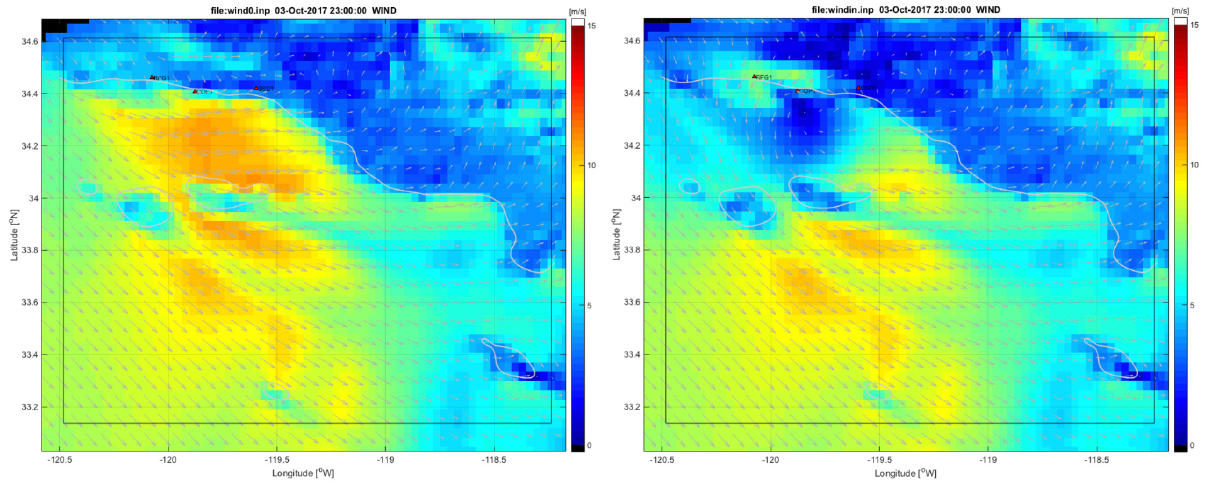
Figure 6. A 10-m wind field comparison for COAMPS first guess (left) and SWAN HF assimilation winds (right) for 3 October 2017 at 2300z. Notice the strong winds in the Santa Barbara Channel in the first guess that is not present in the assimilation